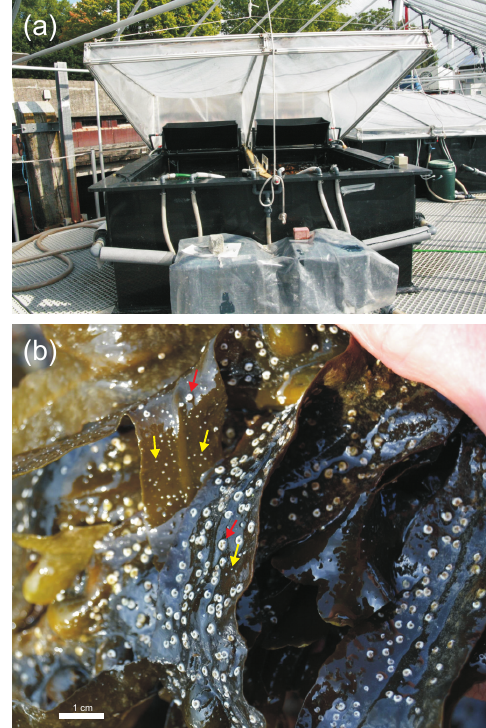
Figure 1. (a) Two subunits of the Kiel Outdoor Benthocosm with open hood. Subunits with closed hoods are visible in the back- ground on the right. (b) Spirorbis spirorbis specimens attached to living brown alga Fucus vesiculosus . Juvenile (white dots, yellow arrows) and adult (white spires, red arrows) specimens of S. spiror- bis are